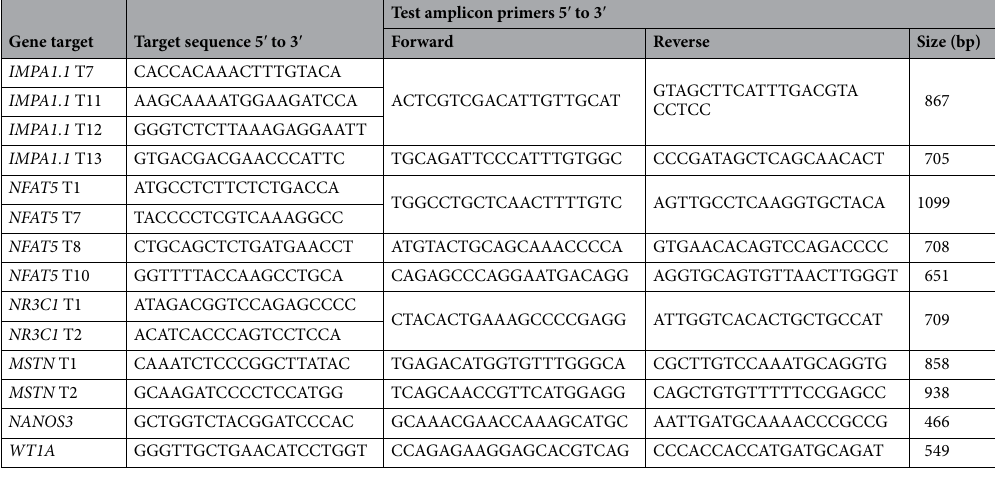
Table 1. Target sequences, primer pairs used to generate test amplicons by PCR, and sizes of un-digested test amplicons used in RSM analysis of diverse gRNA target testing of the Cas9-OmB1 cell